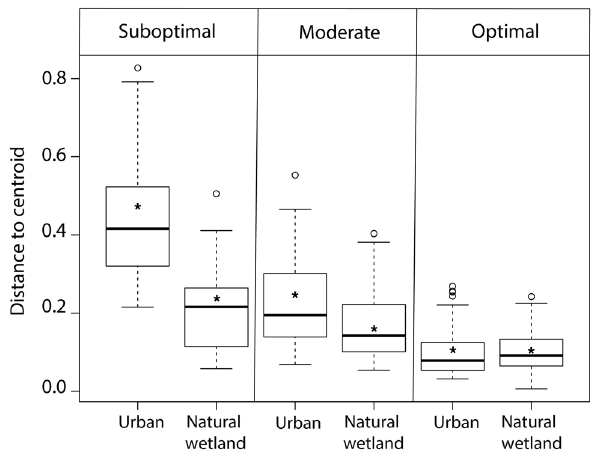
Figure 2. Variation in diet breadth of storks across landscape type (urban and natural wetland) and hydrologic condition (suboptimal, moderate, optimal), South Florida, 2015–2017. Diet breadth was determined as species dispersion in diet space using PERMDISP. A greater distance to centroid indicates a larger dispersion in diet. Within each box plot, the dark central horizontal line represents the median, the top and bottom horizontal lines are the first and third quartiles, respectively; and the whiskers are the range of values within 1.5 inter- quartile ranges of the first and third quartiles. Open circles represent outliers and asterisks represent mean diet breadth for each group.